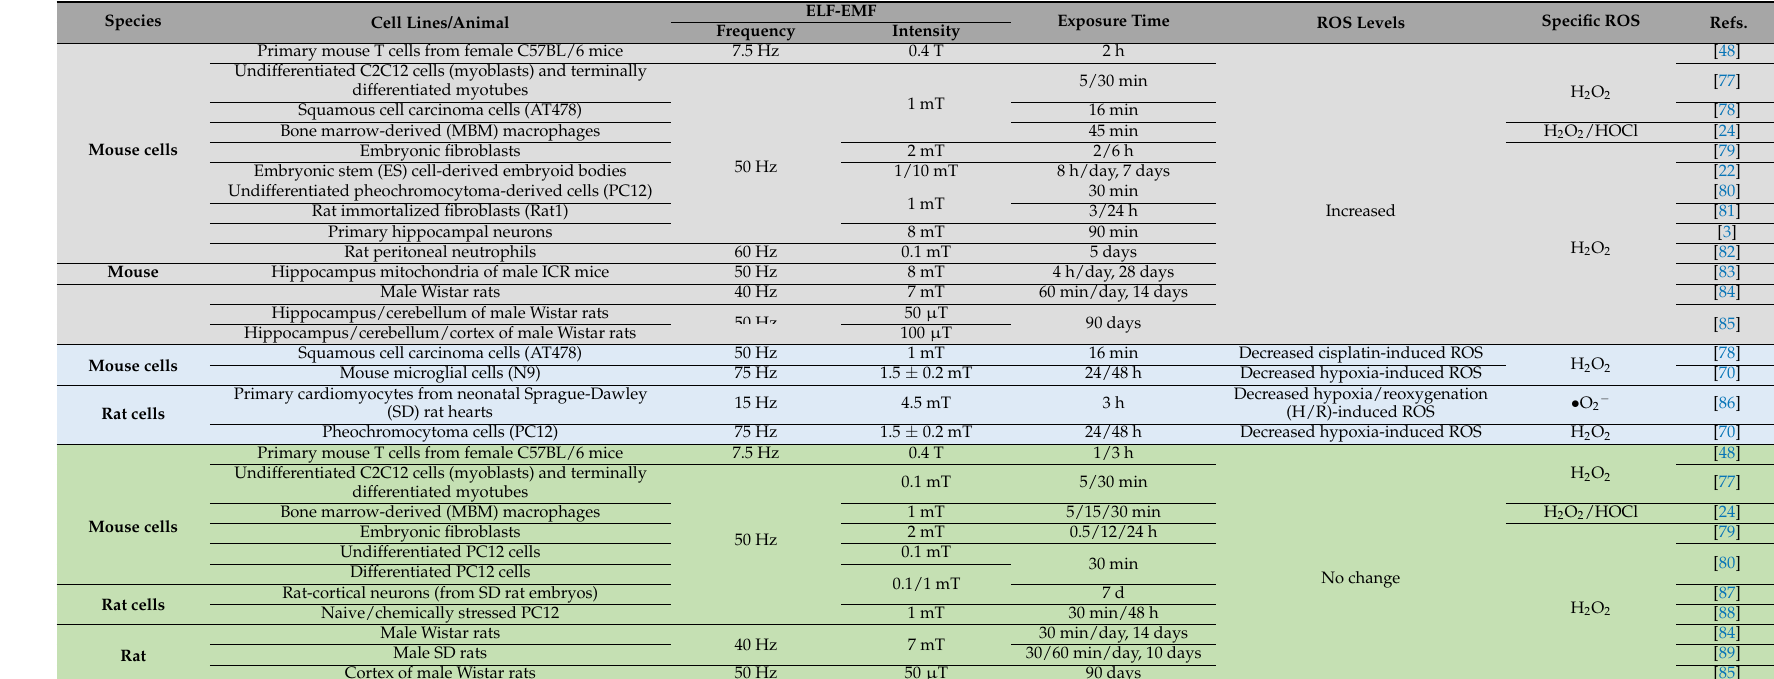
Table 4. ROS changes in mice and rats induced by